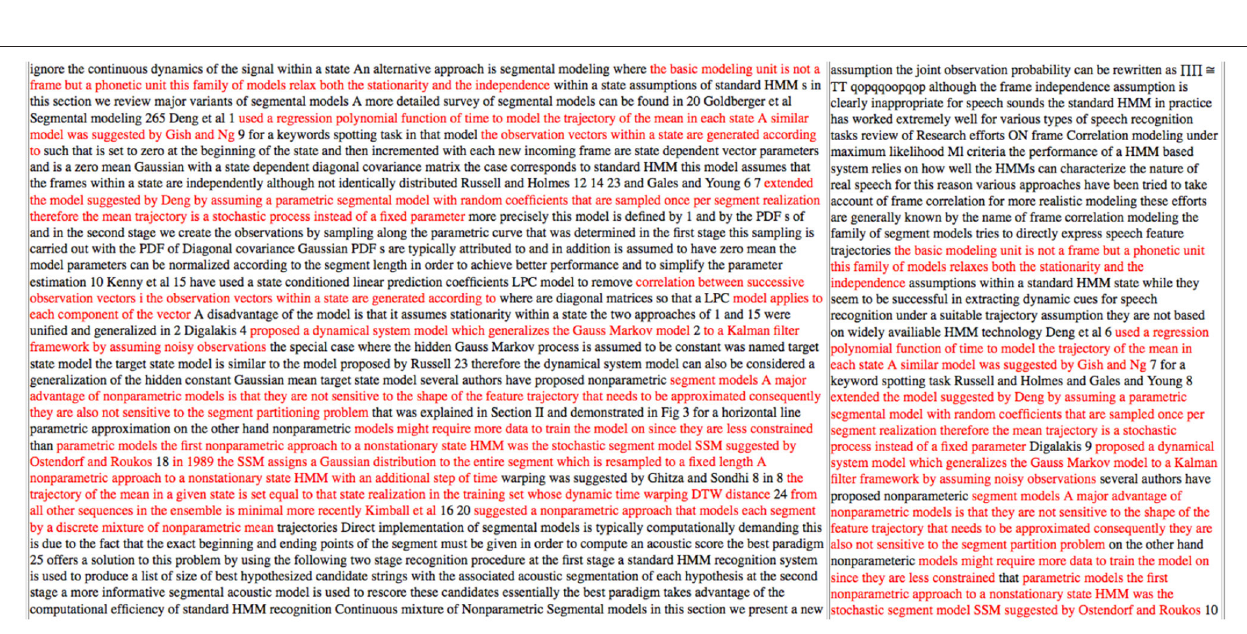
FIGURE 25 | Example in ICASSP 2001 of common fragments (marked in red) for couple 5 articles showing a global similarity score of 0.10 (10%).